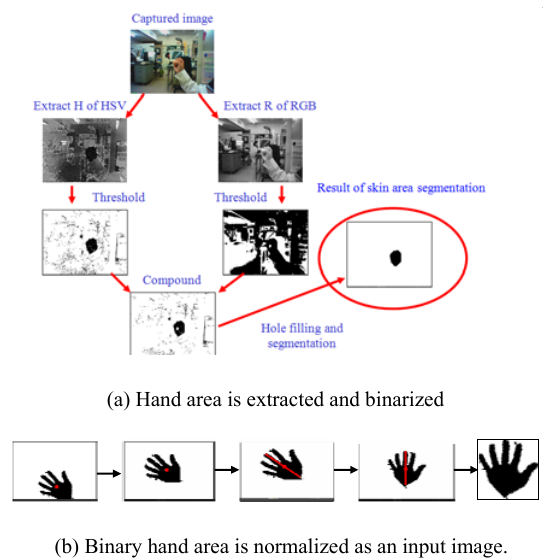
Fig. 5. Hand shape